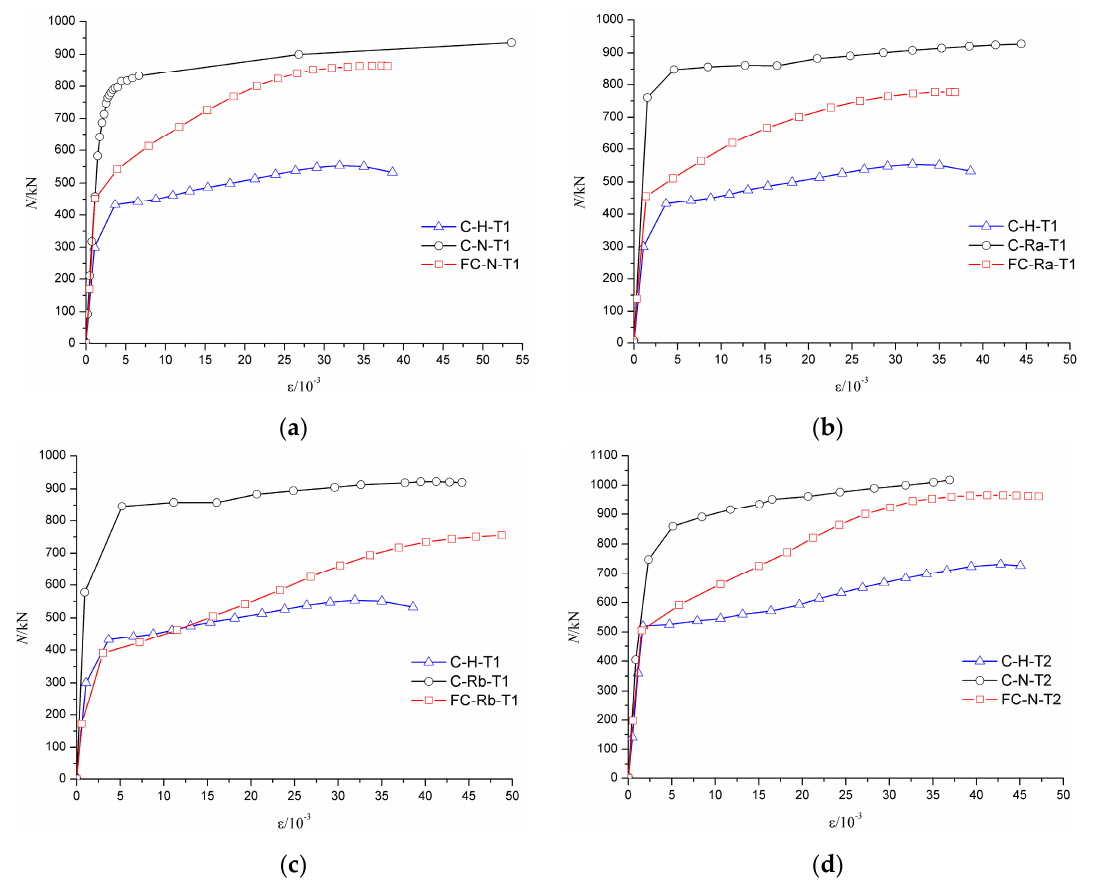
Figure 26. Load–strain curves of specimens before and after fire. ( a ) Fine aggregate concrete (wall thickness is 4 mm); ( b ) Recycled aggregate concrete-Ra (wall thickness is 4 mm); ( c ) Recycled aggregate concrete-Rb (wall thickness is 4 mm); ( d ) Fine aggregate concrete (wall thickness is 5 mm).